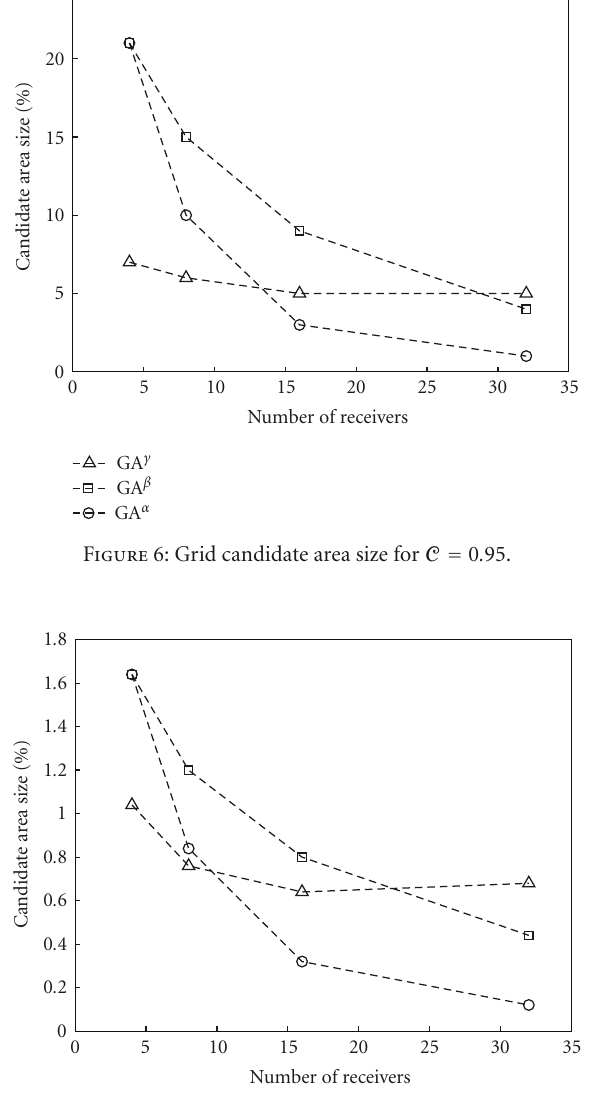
Algorithm 4. Two metrics are aggregated over the executions: the root mean square location error , as the distance in meters between the actual transmitter location p i and its estimated position (cid:13) p i = Vχ i ; and the root mean square angle error